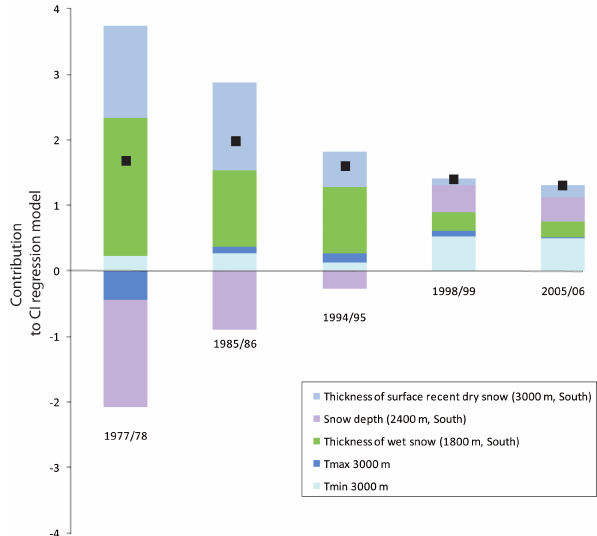
β j of each covariate for years in which Fig. 6. Contribution X . jt both the composite index and its regression model exceed the 90th percentile threshold, for the whole French Alps. Black squares rep- β j resent the modelled anomalies of CI P X . jt